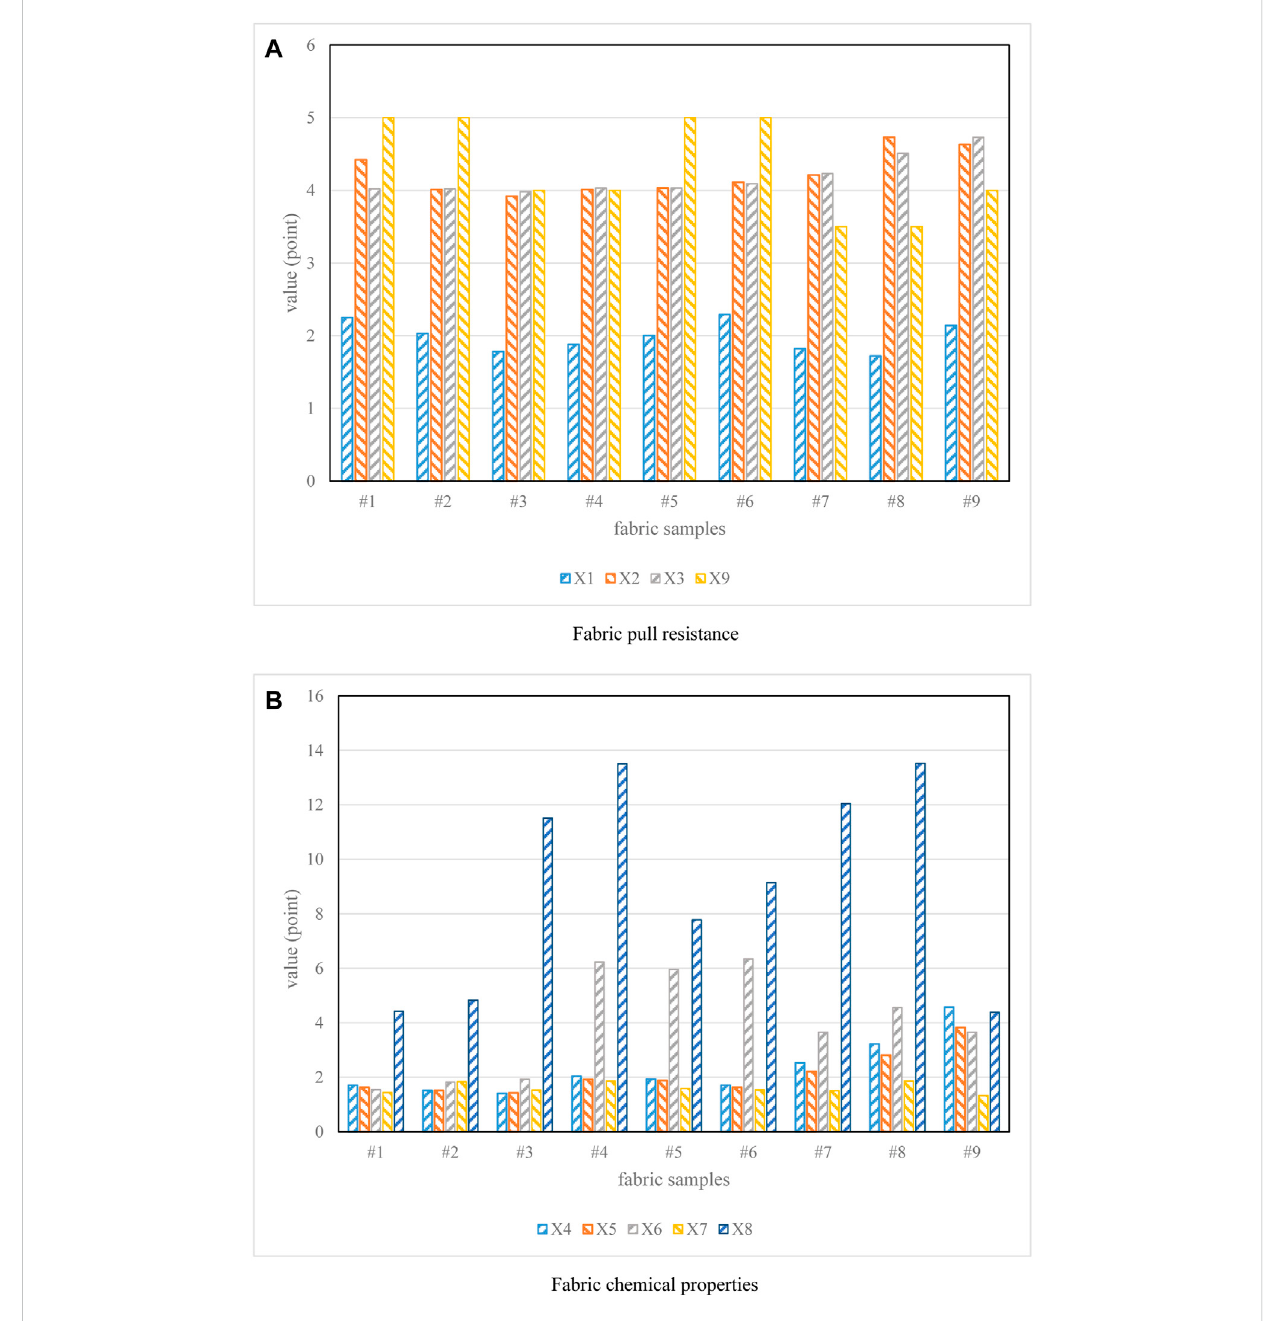
FIGURE 9 Wearing properties of fabrics. (A) Fabric pull resistance. (B) Fabric chemical